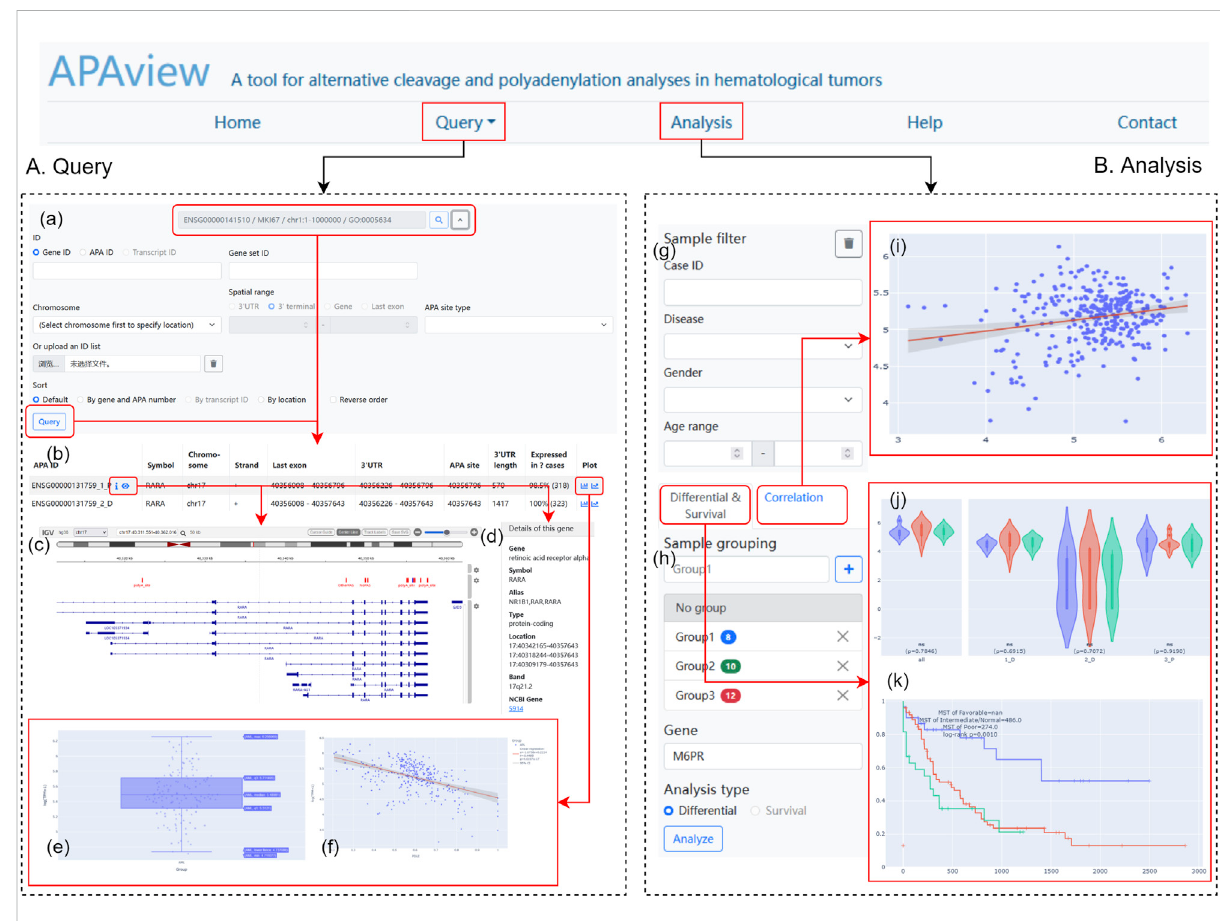
FIGURE 2 Web interface of APAview. (A) On the “ Query ” page, gene/transcript symbols can be inputted (a) , and the retrieved APA information is shown in table (b) . APA sites, 3 ′ UTR, PASs, RBP-, miRNA-binding, and gene structures are shown by IGV (c) . Gene annotation from NCBI is provided (d). PAU/ PDUI distribution (e) and the correlation between PAU/PDUI and gene expression (f) are shown in interactive plots. (B) On the “ Analysis ” page, samples could be fi ltered (g) and grouped (h) based on clinical information. Results of correlation (i) , differential (j) , and survival analyses (k) are shown in interactive plots. PAS, PolyA signal; RBP, RNA-binding protein; PAU, PolyA site usage; PDUI, percentage of distal PolyA site usage